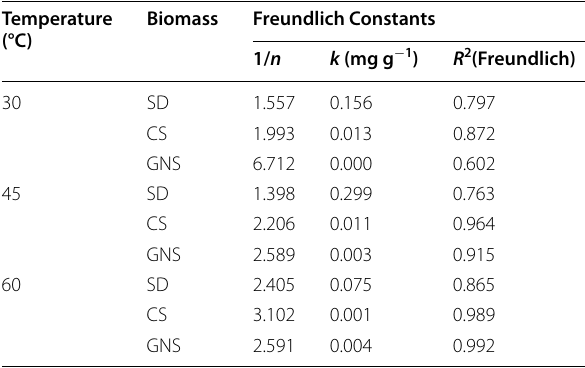
Table 3 Values of Freundlich constants k , 1/ n and R 2 for SD, CS and GNS at 30 °C, 45 °C and 60